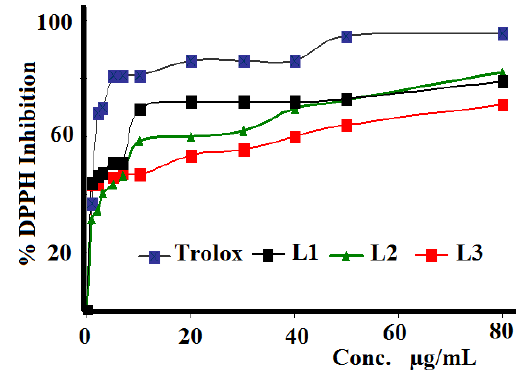
Figure 9. DPPH free radical scavenging curve of L1–L3 as compared to the Trolox standard reference.